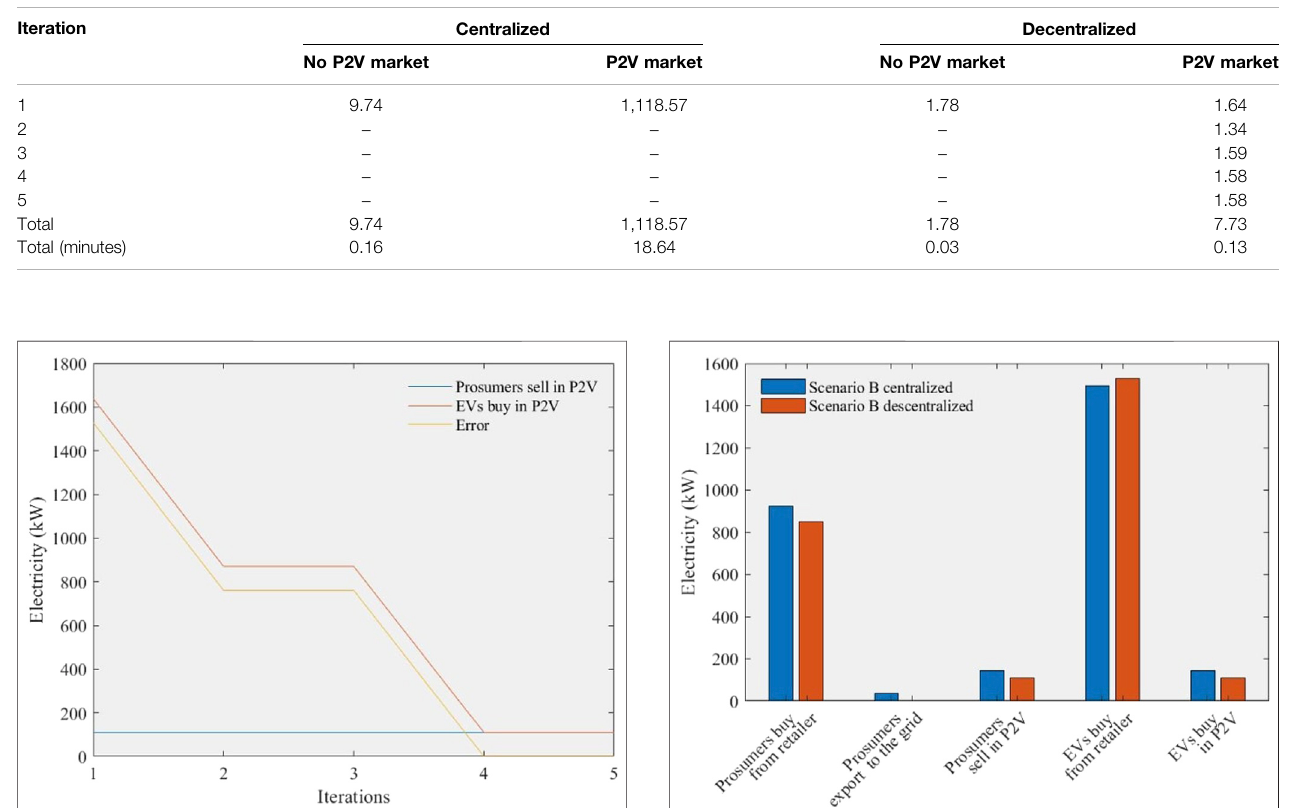
TABLE 5 | Optimization time results (seconds).